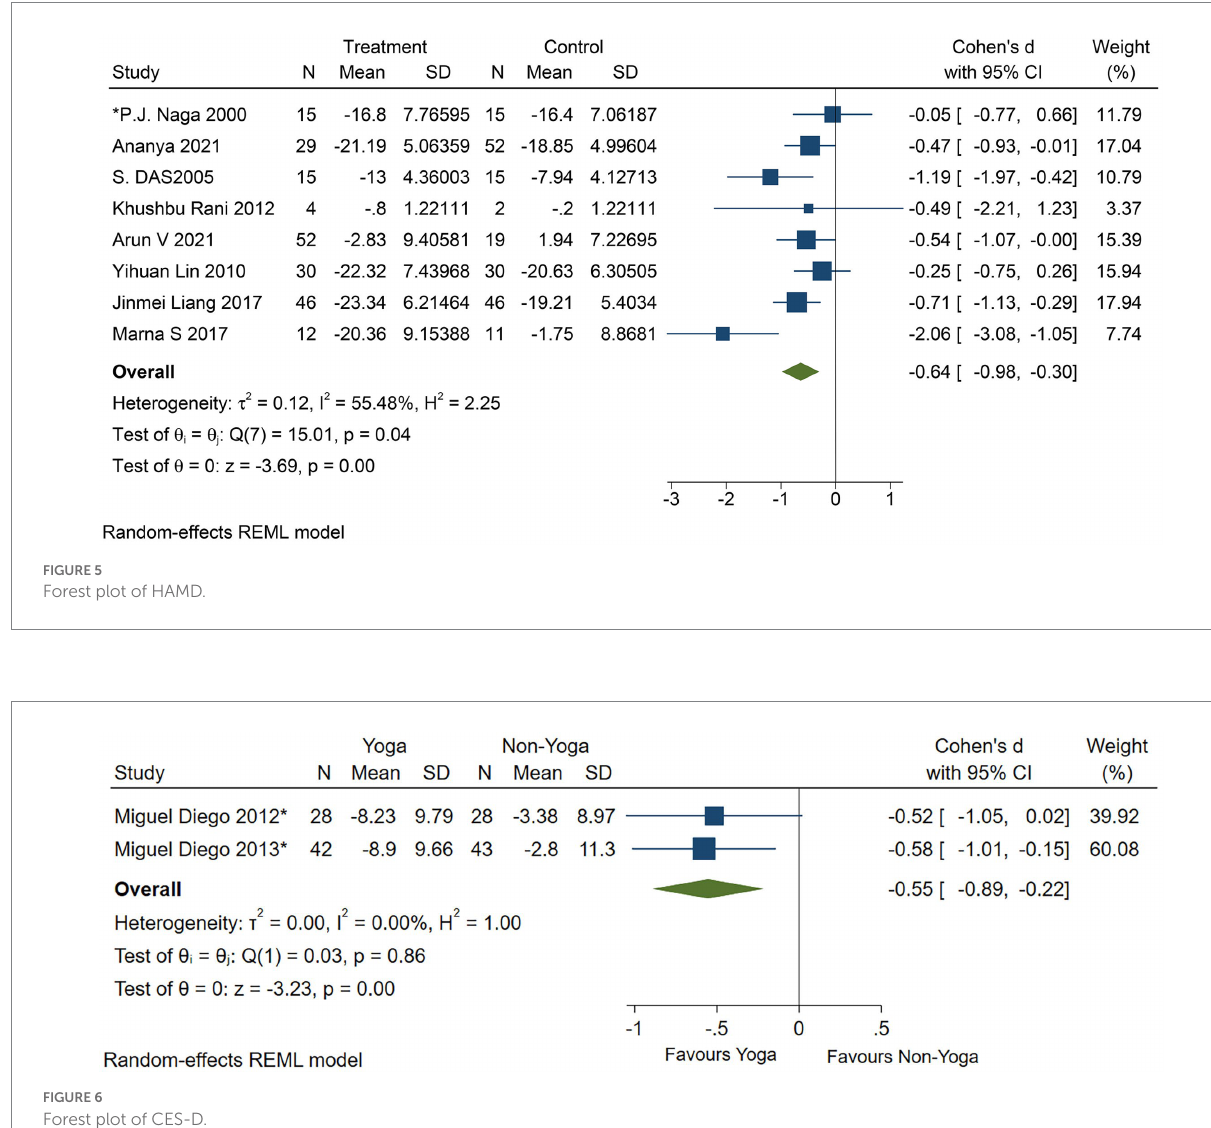
FIGURE 6 Forest plot of CES-D.